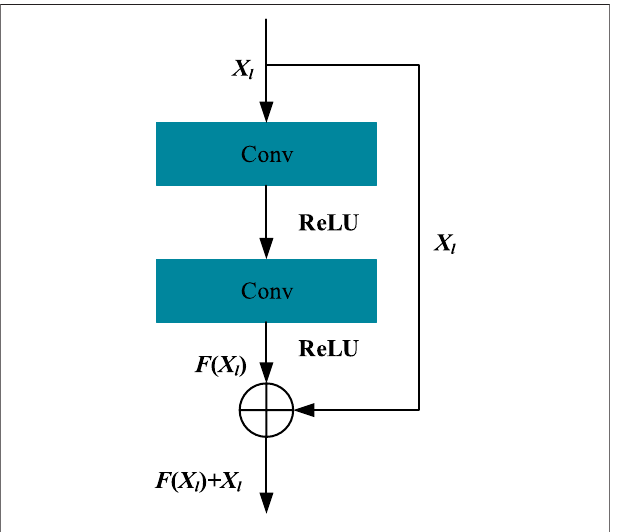
FIGURE 2 | Structure of the residual